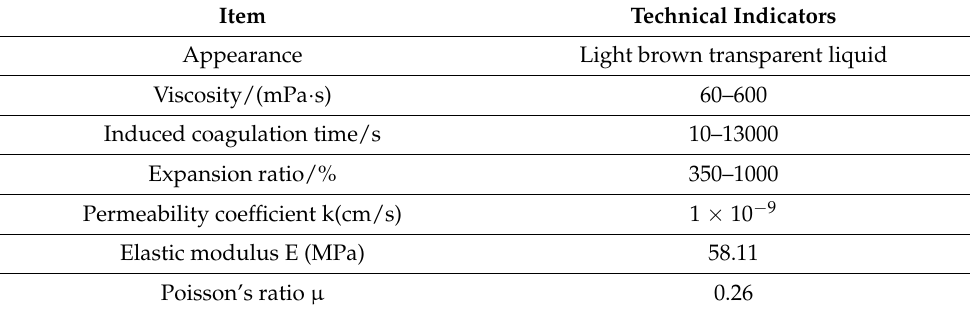
Table 2. Polymer technical indicators.